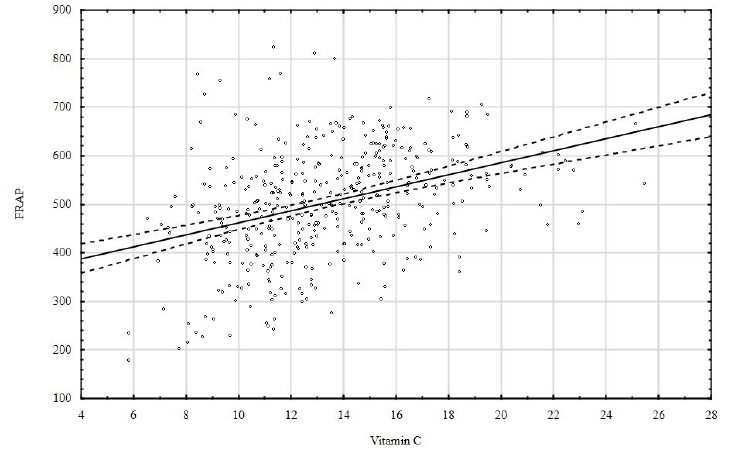
Figure 5. Relationship between vitamin C concentration and FRAP ( r = 0.36696, 0,95 confidence interval).